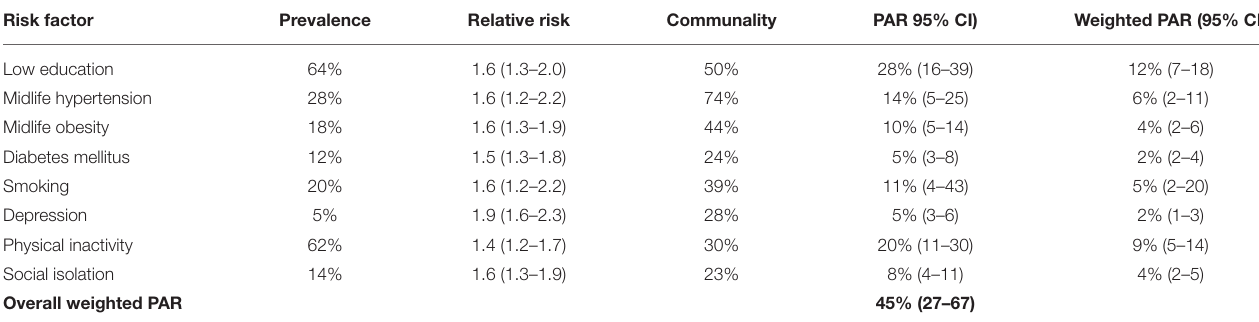
TABLE 1 | Risk factor prevalence in South Africa, relative risk associated with dementia, communality, Population Attributable Risk (PAR), and weighted